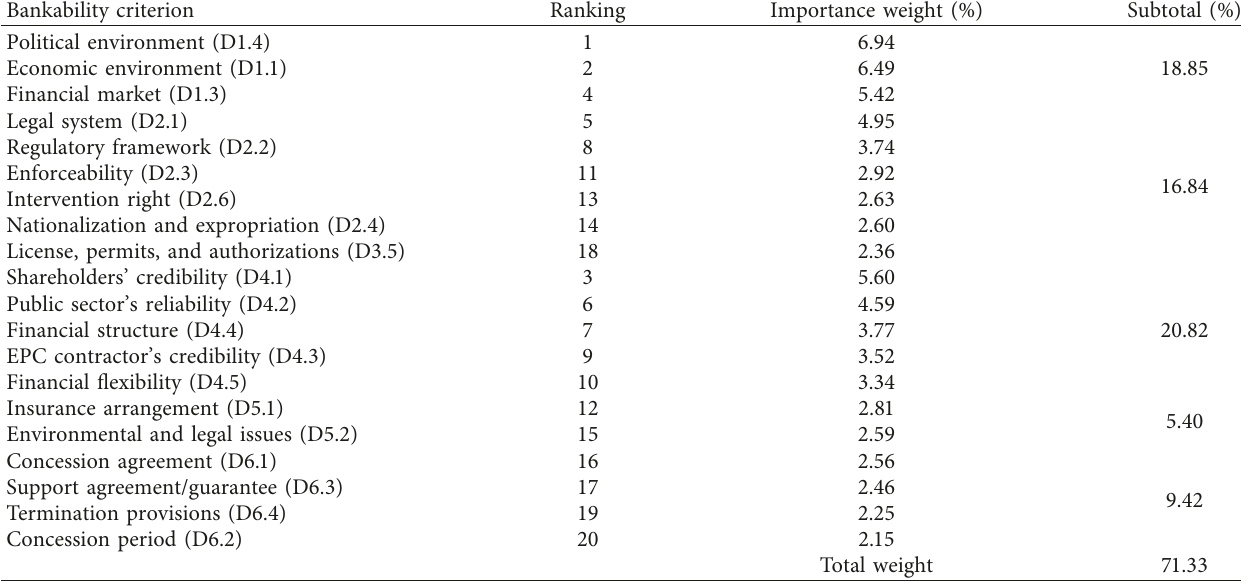
Table 4: Relative importance weights of the twenty criteria from the banks’